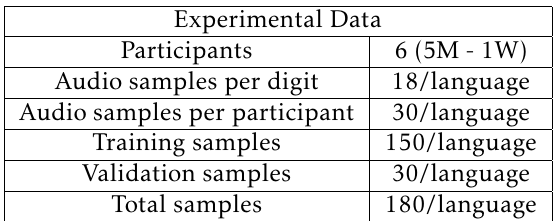
Table 1. Experimental and participants data.